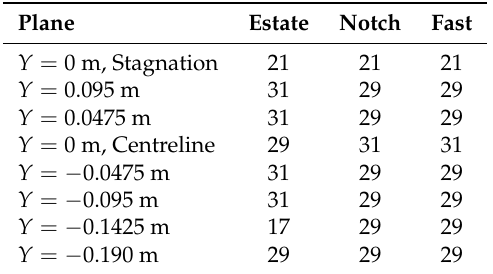
Table 2. Value of dt ( µ s) for each plane and